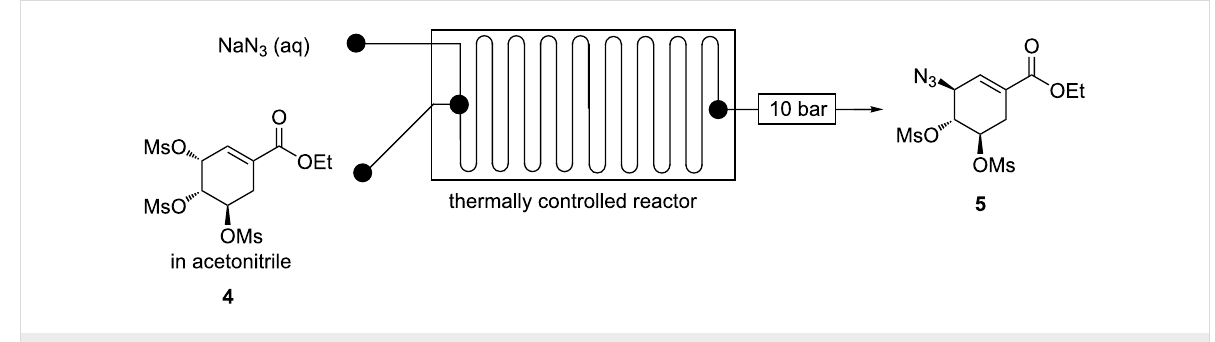
Figure 2: Continuous-flow system for C-3 azidation of mesyl shikimate using aqueous sodium azide.